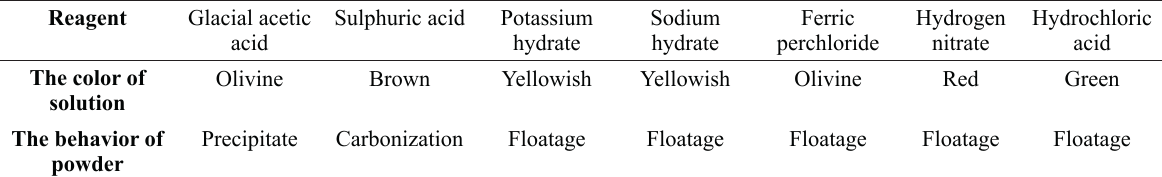
The behavior study of powder of Desmodium